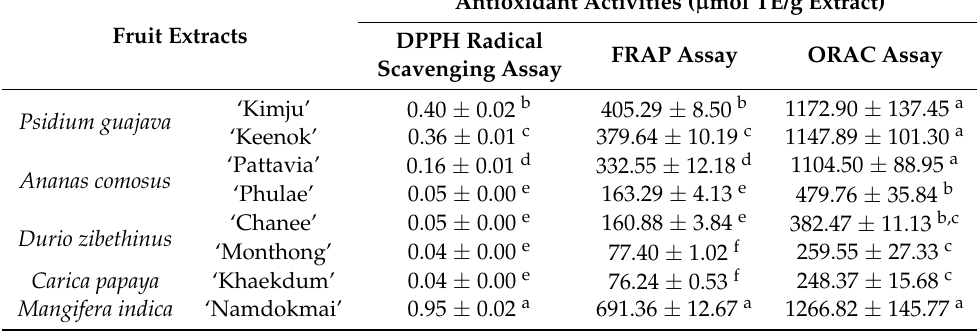
Table 2. Antioxidant activities of the fruit extracts.